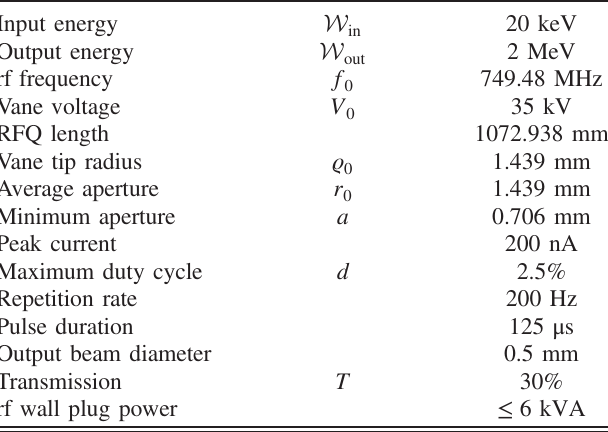
TABLE I. Design parameters of the PIXE RFQ.